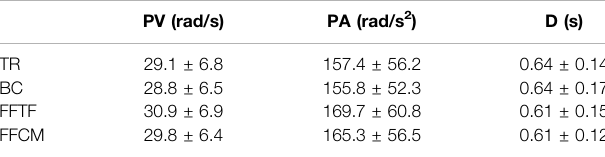
TABLE 3 | Means and standard deviations of standard descriptors of human